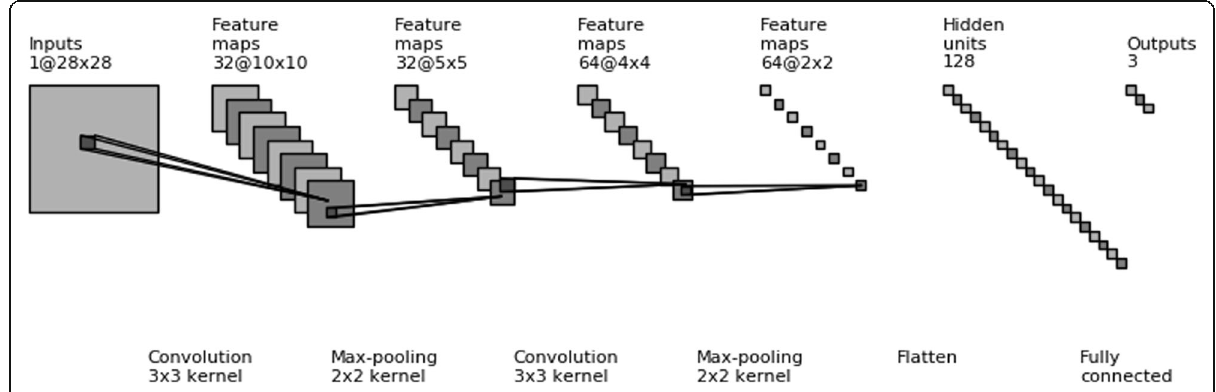
Fig. 5 CNN structure for classifying rale, rhonchus, and normal sounds